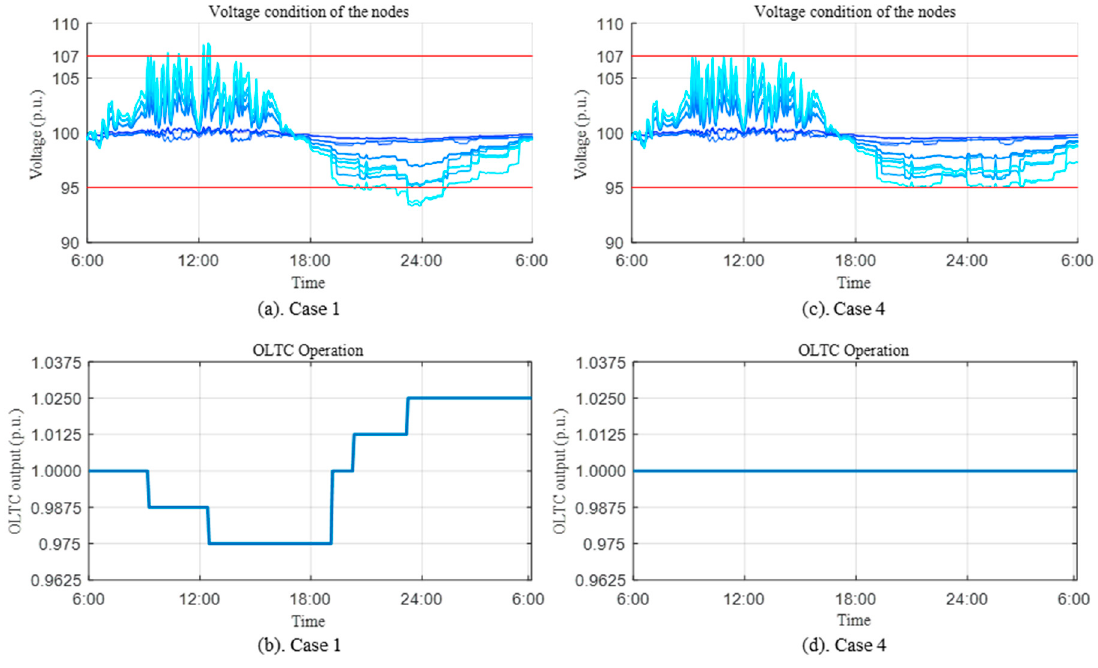
Figure 17. Voltage condition and OLTC operation of Case 1 and Case 4 using the model of Reference [23].